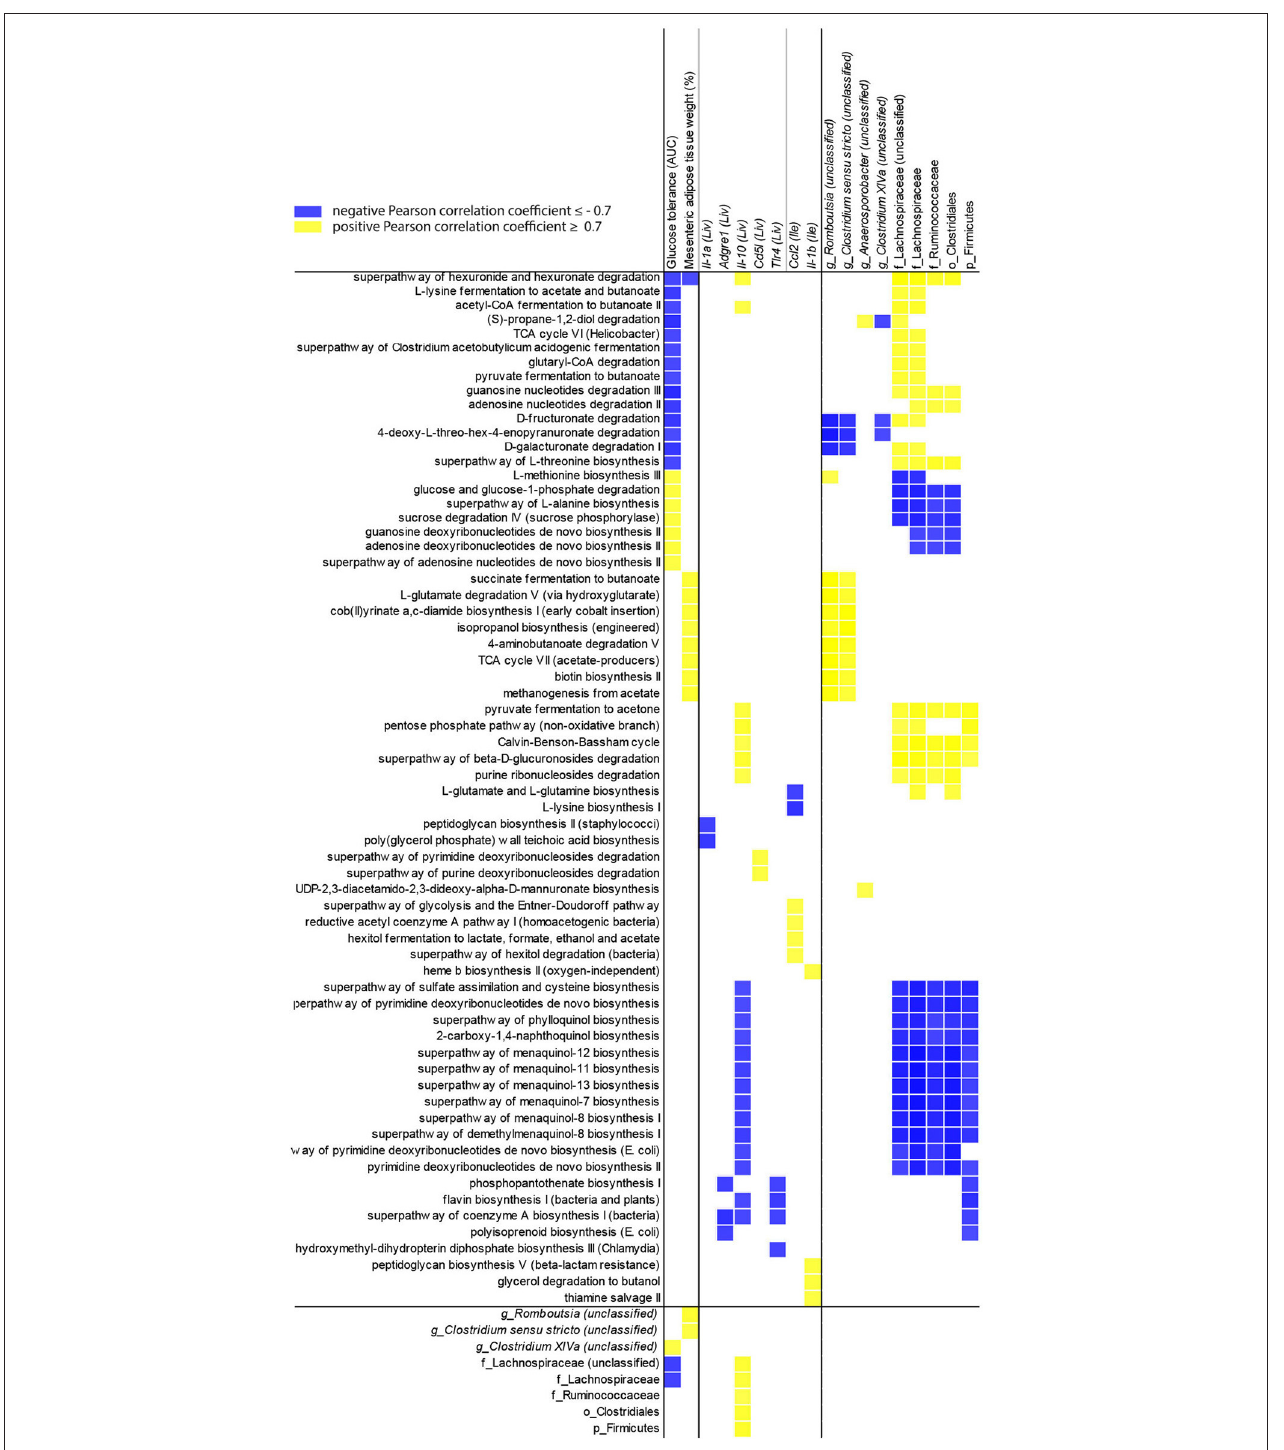
FIGURE 7 | Changes in microbiota predicted functional pathways induced by P. gingivalis infection correlate with reduced glucose tolerance in mice fed a WD. Correlations between glucose tolerance test performance represented as the area under the curve, mesenteric adipose tissue weight, or gene expression and MetaCyc pathway abundance predicted from 16S rRNA gene sequencing of the cecal microbiota of WD-fed mice either infected with P. gingivalis or treated with vehicle. Host phenotype: Glucose tolerance = area under the curve during a glucose tolerance test (mg/dL); Mesenteric adipose tissue weight (%) = weight of mesenteric adipose tissue as a percent of total body weight. All pathways correlated with host phenotype or gene expression (cutoff = + / − 0.7) were included, as well as any taxa they correlated with. Yellow = direct correlation (positive Pearson correlation coefficient), blue = direct correlation (negative Pearson correlation coefficient).